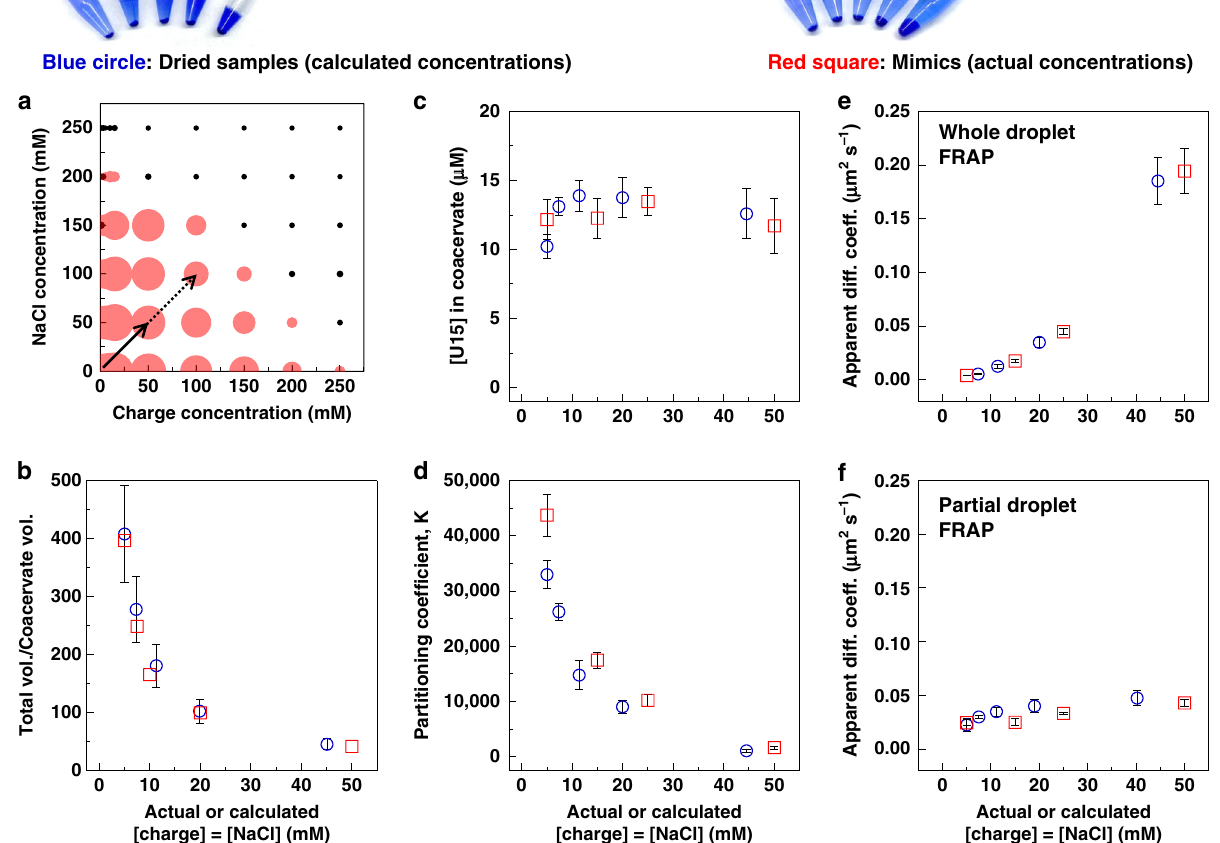
Fig. 5 Comparison between dried coacervates and composition mimics samples. a The solid line on the phase diagram, obtained by turbidity measurements, shows the range of the composition mimics. The dotted line shows the extension where the SAXS measurements were performed (Fig. 6). b Total volume of solution to coacervate phase volume ratio. The error bars in b represent a constant standard deviation of ±0.25 µ L, a difference in volume that was dif fi cult to discern with the naked eye (Supplementary Fig. 22). c U15 concentrations measured within the coacervate. d Partitioning coef fi cient of U15 ([U15] coacervate phase /[U15] dilute phase ). e Whole-droplet FRAP, and f partial-droplet FRAP in dried PDADMA/PAA coacervate samples and mimics with compositions on the same range obtained during drying. Error bars in c – f represent standard deviations among different trials and individual data points are shown in the SI (Supplementary Fig. 24, Supplementary Tables 8 and 9). In c , mimics data represent means and standard deviations of three trials with 15 droplets analyzed over three images, per trial. FRAP mimics data are averages and standard deviations obtained from three trials with at least two bleached droplets per trial for whole-droplet experiments, and three bleached areas per sample for partial-droplet measurements. Photos of bromophenol blue-dyed dried and mimics samples are included above for clari fi